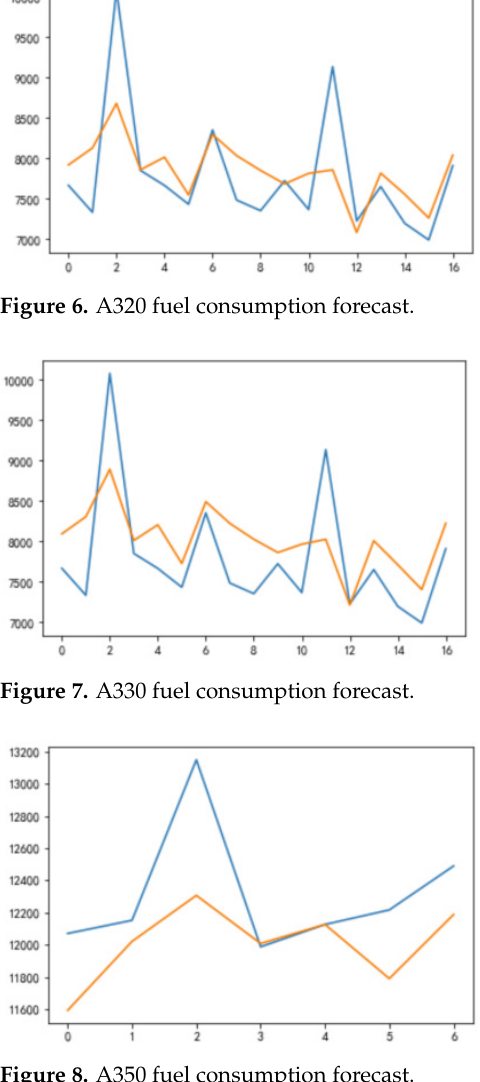
Figure 5. A319 fuel consumption forecast.